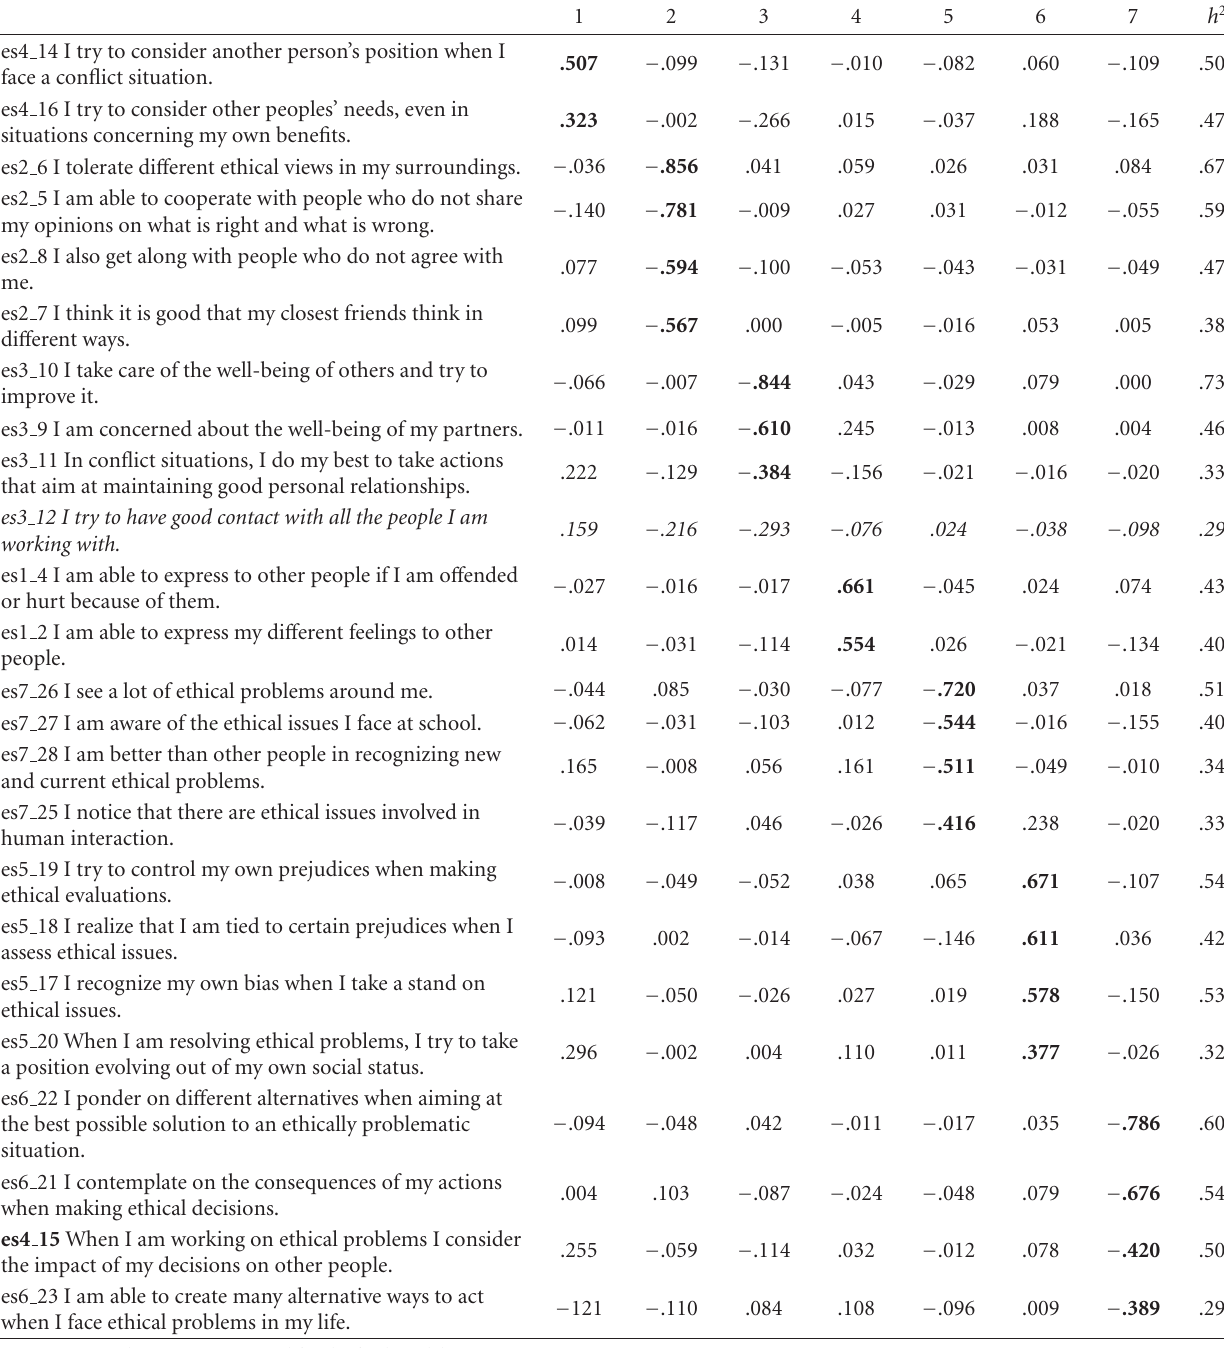
Table 5: Factor loadings and extraction